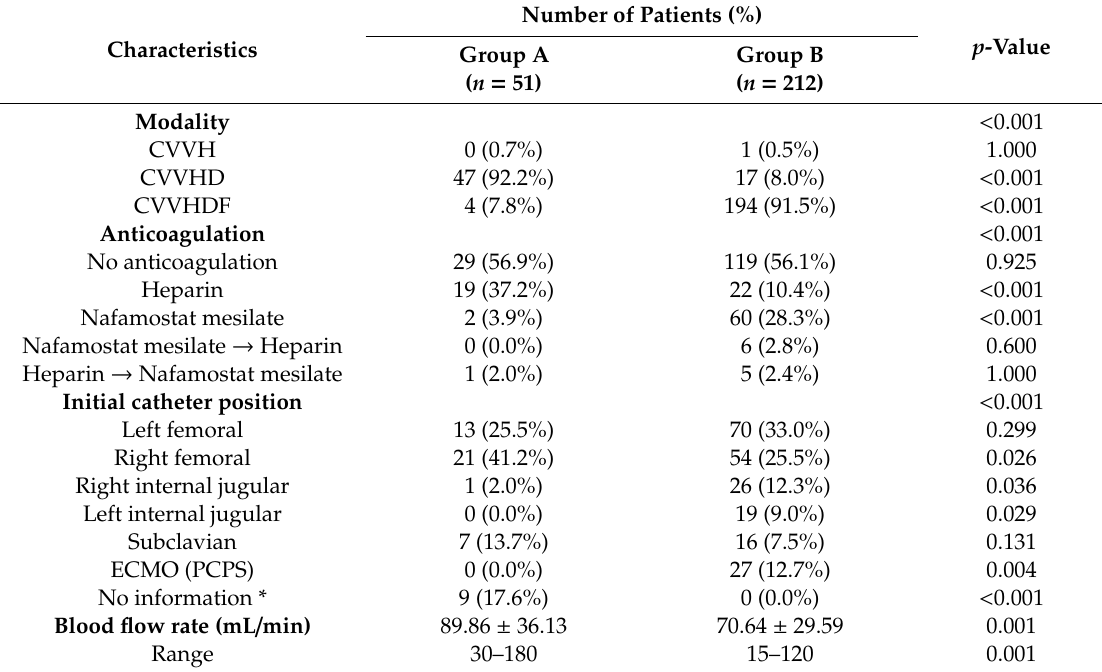
Table 5. Technical characteristics of